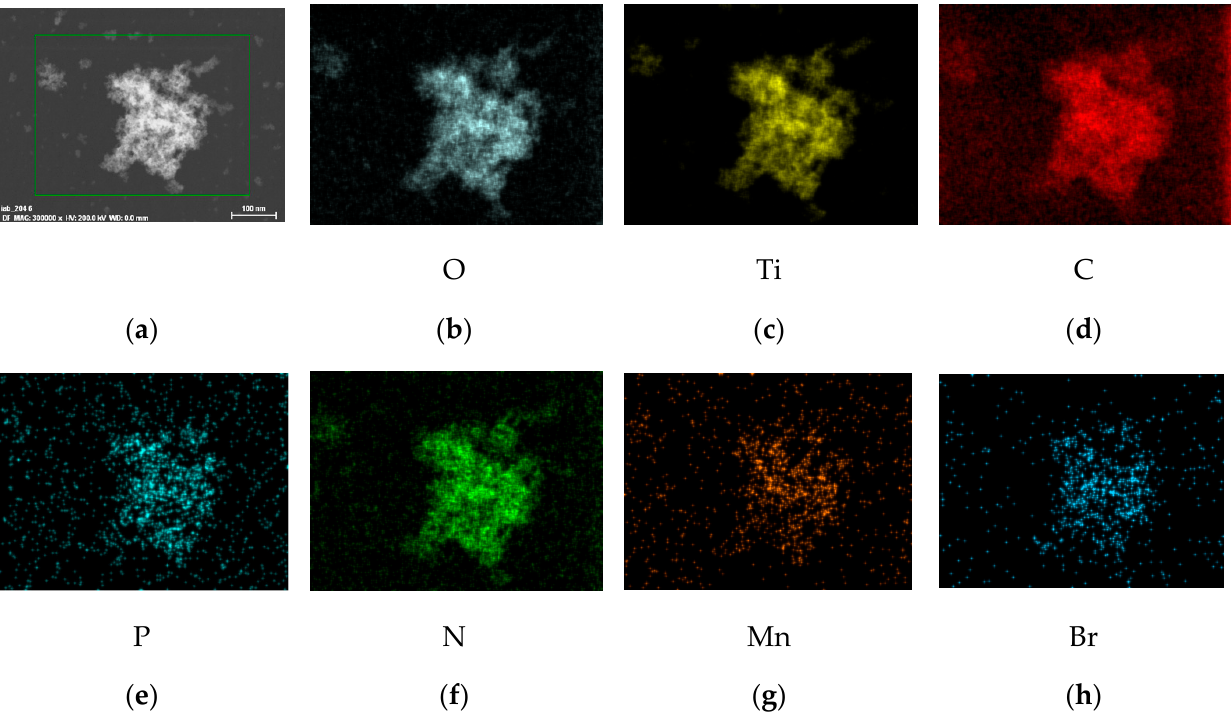
Figure 3. STEM image of Mn(TMPIP)/TiO 2 before the analysis ( a ) and EDS elemental mapping images of Mn(TMPIP)/TiO 2 ( b – h ): O ( b ), Ti ( c ), C ( d ), P ( e ), N ( f ), Mn ( g ), Br ( h ). The acquisition time, i.e., exposure to the electron beam, was 1 h.